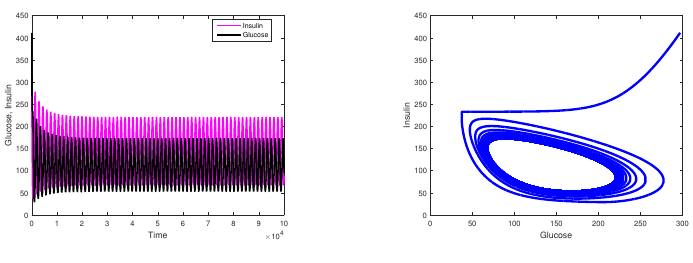
Figure 6. Glucose-insulin dynamics: dynamics and phase plain for τ = 500 > τ ∗ = 457 min. Case 3. For τ g = τ i = τ (cid:54) = 0. For a subject 6, E ∗ = (133 . 8791 , 104 . 6922), w = 0 . 0043